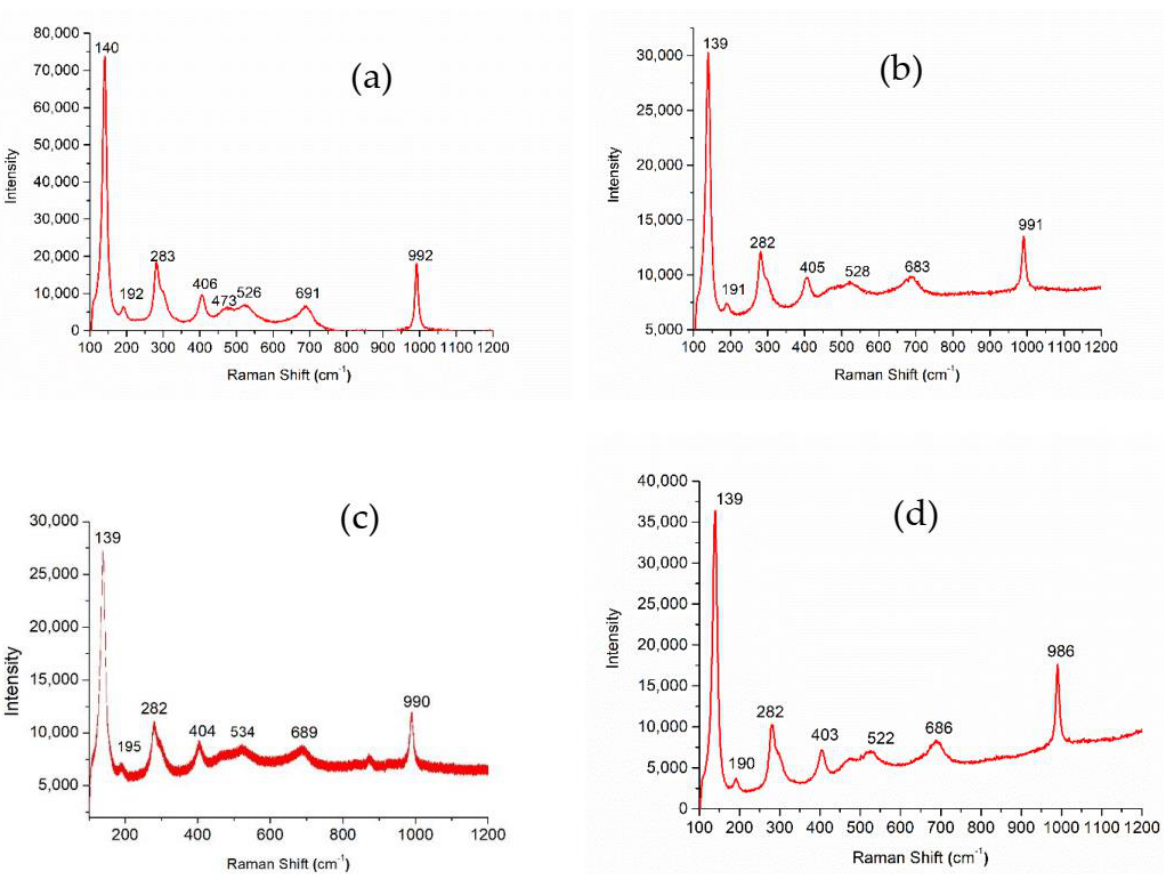
Figure 3. Raman spectra of VO 2 nanoparticles with different morphologies ( a ) asterisk-shaped ( b ) urchin-like, ( c ) multi- faceted spherical ( d ) nanotube.